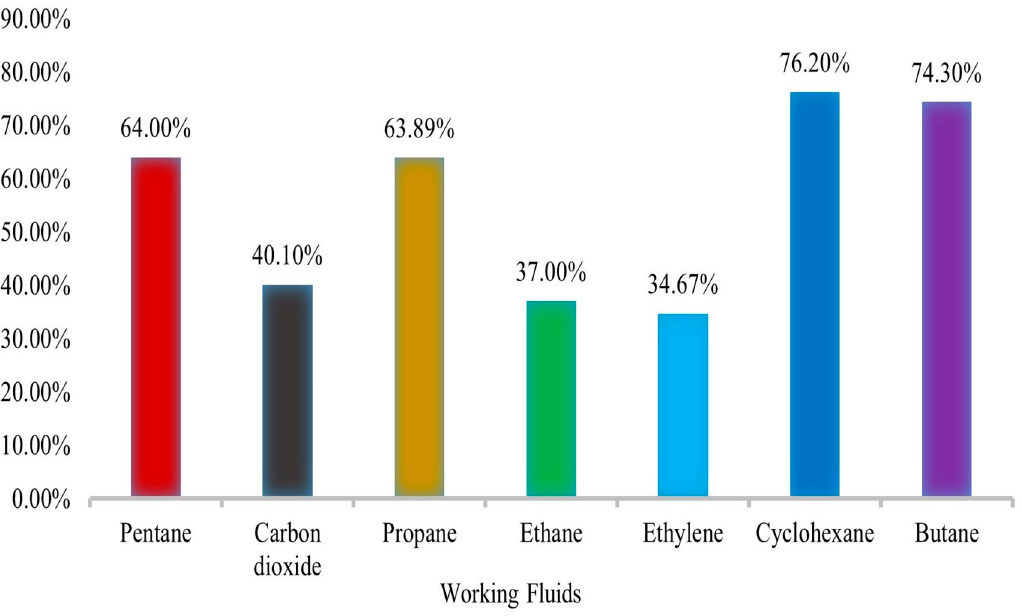
Figure 8. Demonstration on the obtained exergy efficiency percentage using working fluid in a single mode.